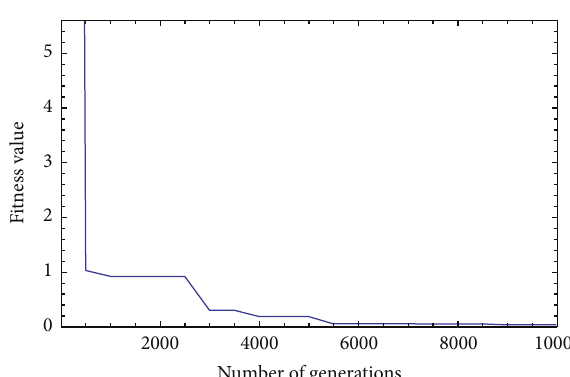
Figure 16: Performance graph for Case 6.